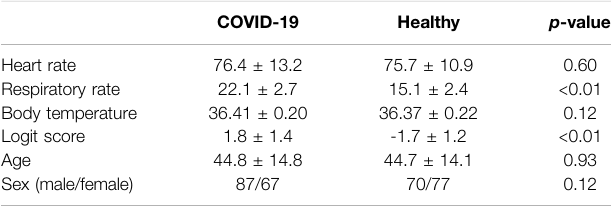
TABLE 1 | Demographics of the patients with COVID-19 and the healthy